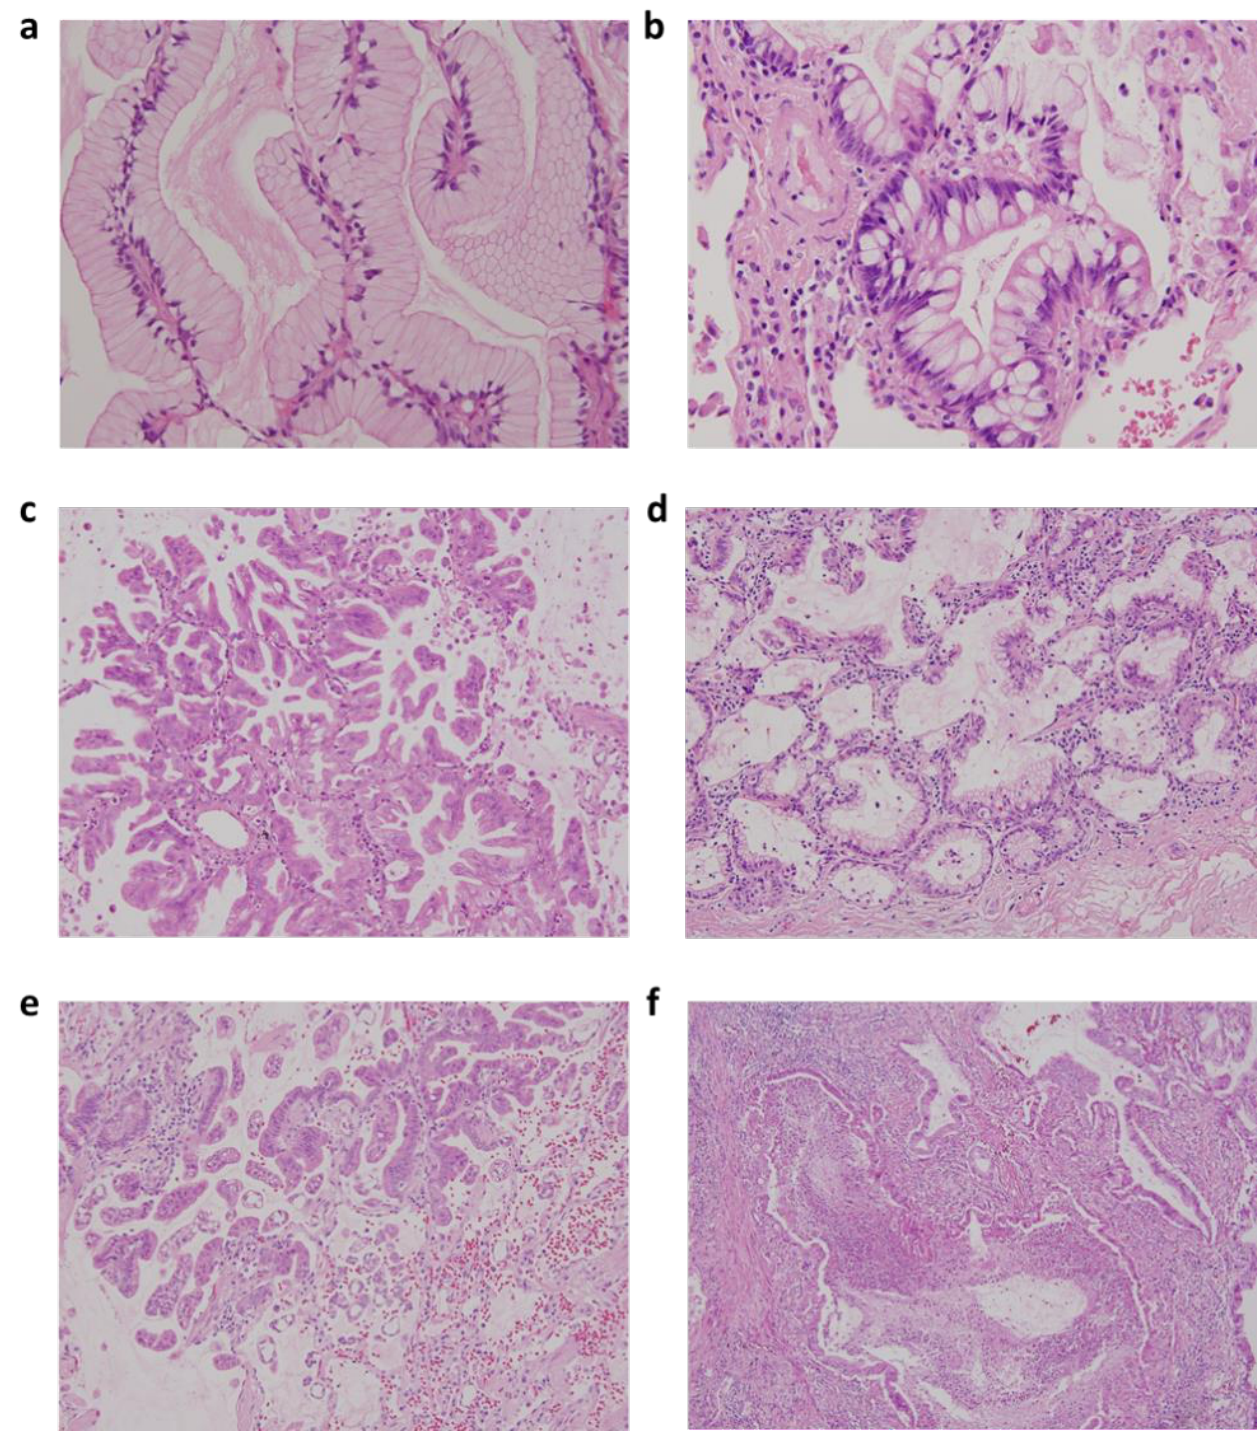
Figure 1. Representative figures of low-grade and high-grade invasive mucinous adenocarcinoma (IMA) according to two-tier IMA-2 grading system in IMA. ( a ) Low-grade IMA with pancreatic intraepithelial neoplasia 1 (PanIN1)-like features with flat mucinous epithelium and basally located nuclei; ( b ) low-grade IMA with PanIN2-like features with nuclear crowding, pseudostratification, and tuft-like growth; ( c ) high-grade IMA with PanIN3-like features with micropapillary or filigreed patterns, decreased mucin production, and vesicular nuclei with conspicuous nucleoli; ( d ) low-grade IMA with mixed PanIN1 and PanIN2-like areas; ( e ) high-grade IMA with mixed PanIN2 and PanIN3-like areas along with STAS; and ( f ) high-grade IMA with complex glands and tumor necrosis (original magnification: A and B, 400 × ; C–F, 200 ×